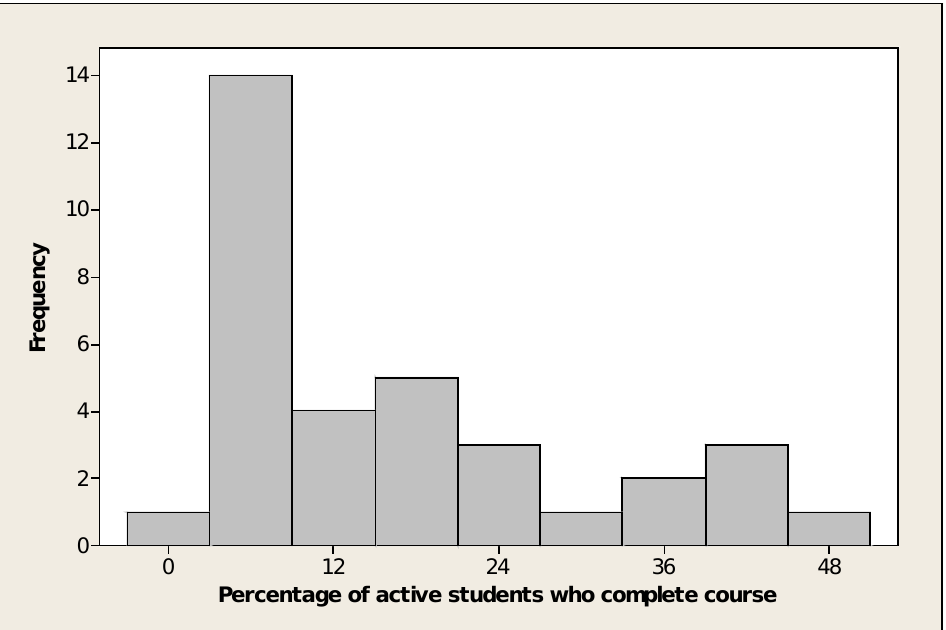
Figure 7 . Histogram of completion rates as a proportion of active students for the sampled courses ( n =